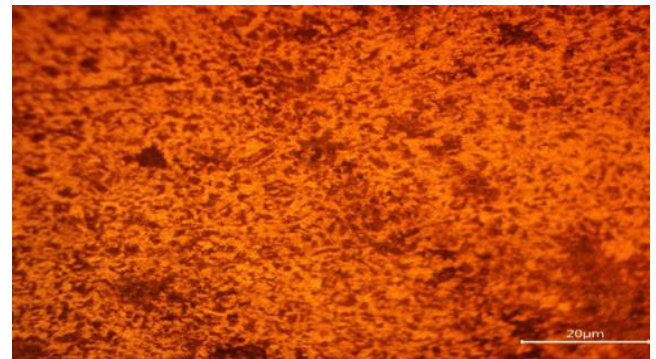
Fig. 7 Microstructural of post welded annealed medium carbon